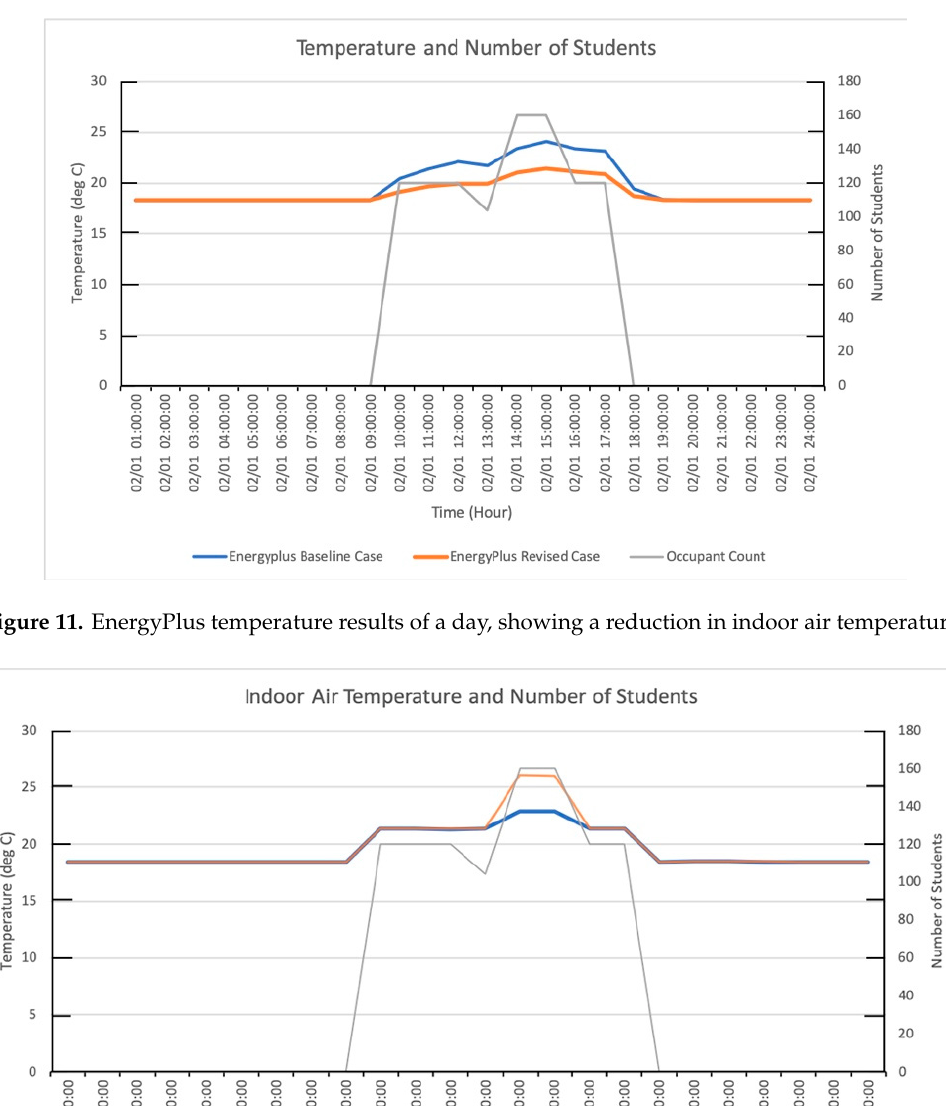
Figure 10. eQUEST temperature results in January with baseline case (red) and revised case 2 (blue), showing a reduction in indoor air temperature when outdoor air flow rate is increased.